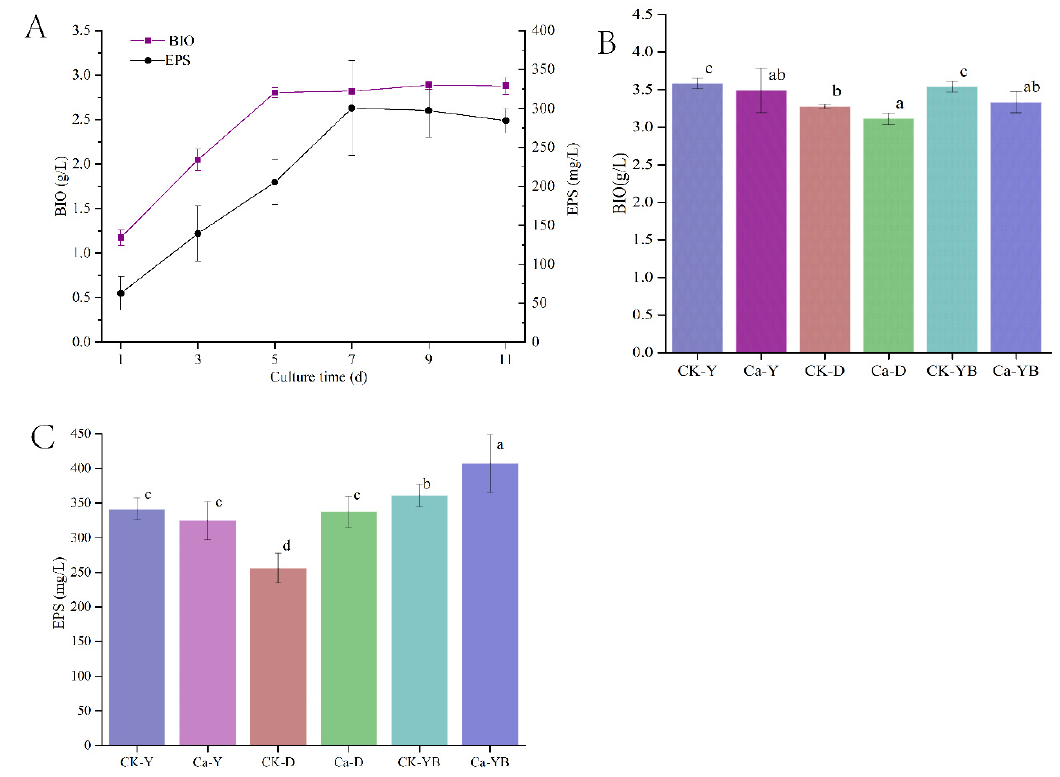
Figure 2. The dynamic curve ( A ) and yellow–blue LED light shift strategy of EPS synthesis ( B ) and mycelia growth ( C ). Among them, CK-Y, CK-D, and CK-YB represented the no mental ion-treated group with yellow, dark, and yellow–blue shift light, respectively. Ca-Y, Ca-D, and Ca-YB represented the Ca 2+ -treated group with yellow, dark, and yellow–blue shift light, respectively.